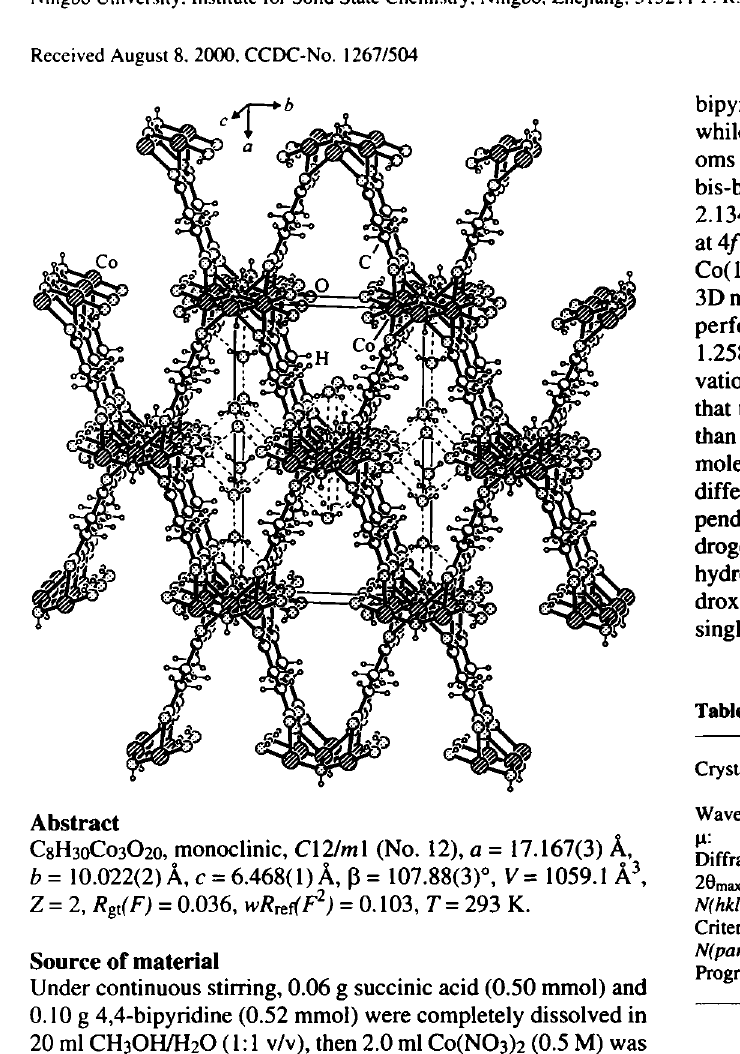
Table 2. Atomic coordinates and displacement parameters (in A 2